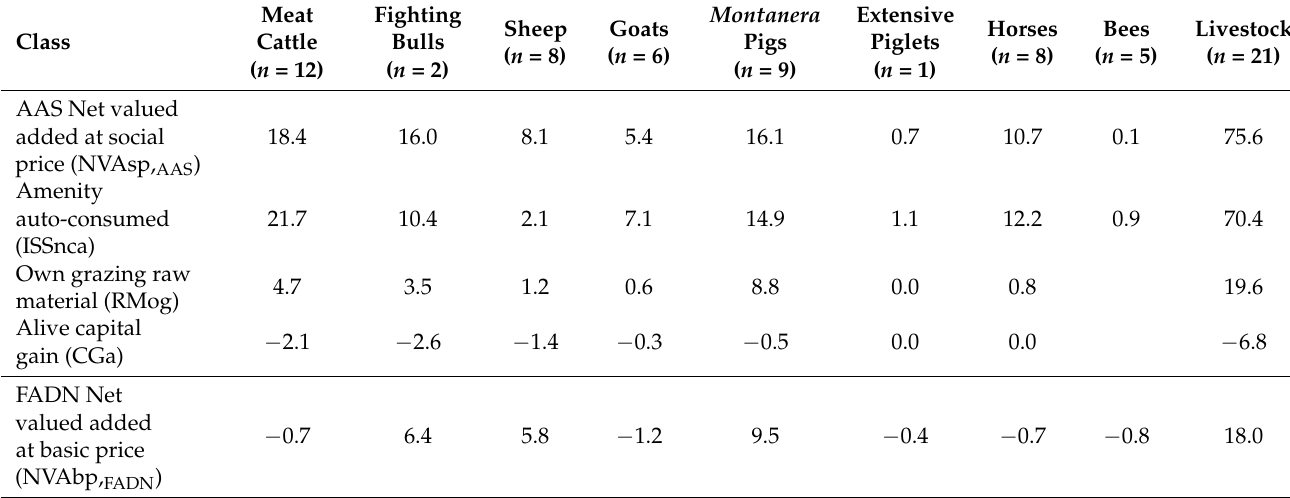
Table 9. Livestock species and activity net value added under the refined Farm Accounting Data Network (FADN) of large privately owned dehesas in Andalusia (2010: